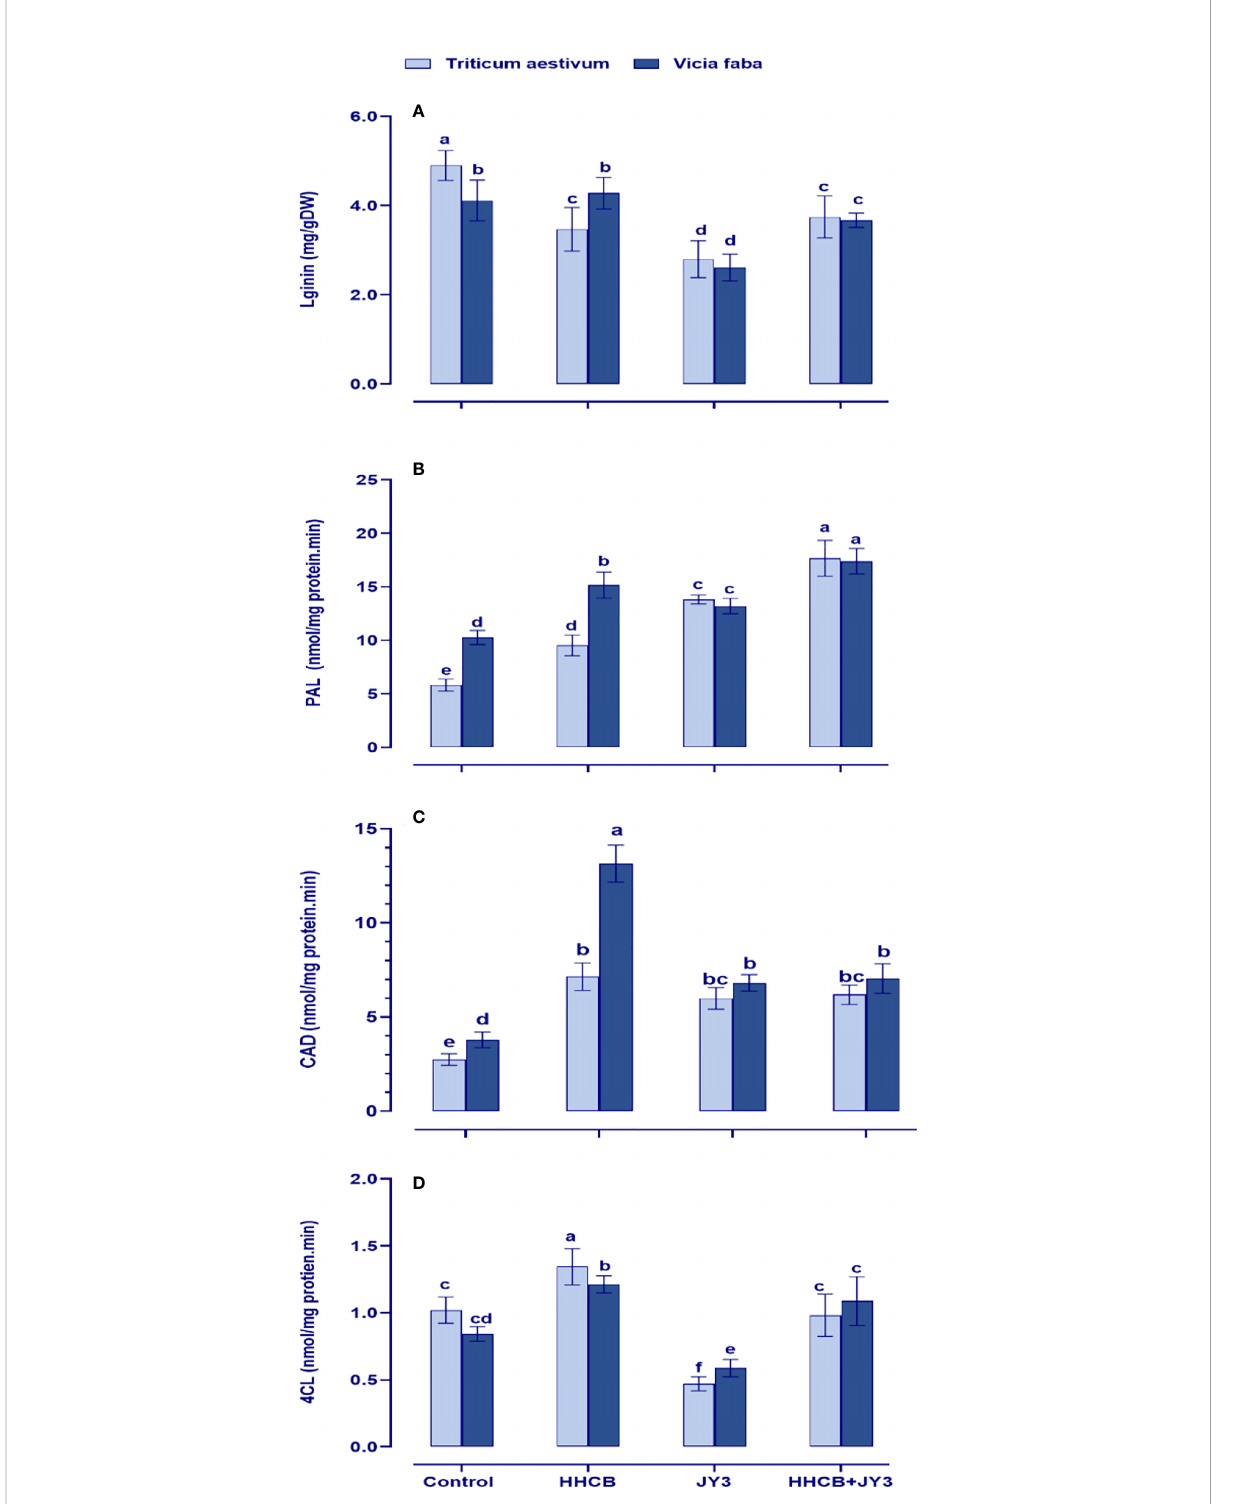
FIGURE 7 Effect of HHCB either alone or in combination with Rhodospirillum sp. JY3 on (A) lignin, (B) phenylalnine ammonia lyase (PAL), (C) cinnamyl alcohol dehydrogenase (CAD), (D) 4-coumarate-coenzyme A ligase (4CL) of both wheat and faba beans. three biological replicates were used to detect each value. the bars on the columns represent error bars(SE). One-way ANOVA test was used to determine the signi fi cant difference between the groups. Similar letters in the bars indicate no signi fi cant dif fi dence between